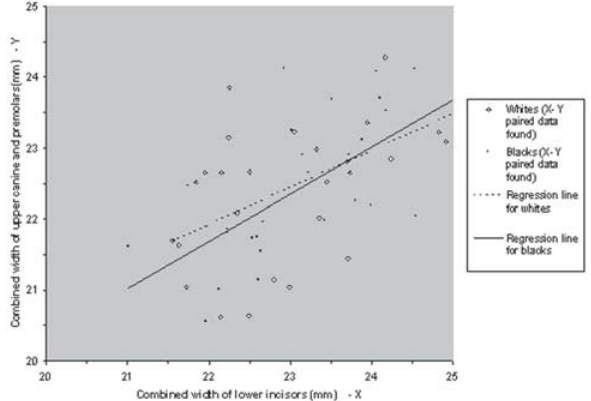
FIGURE 1- Dispersion diagram with regression line of combined mesiodistal crown width of mandibular incisors versus the maxillary canines and premolars in males, according to the patient’s